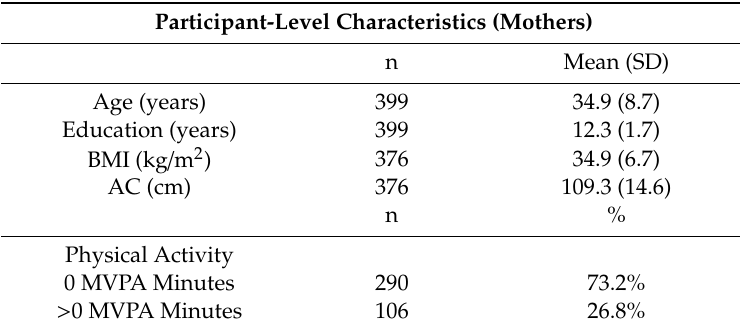
Table 1. Participant- and household-level